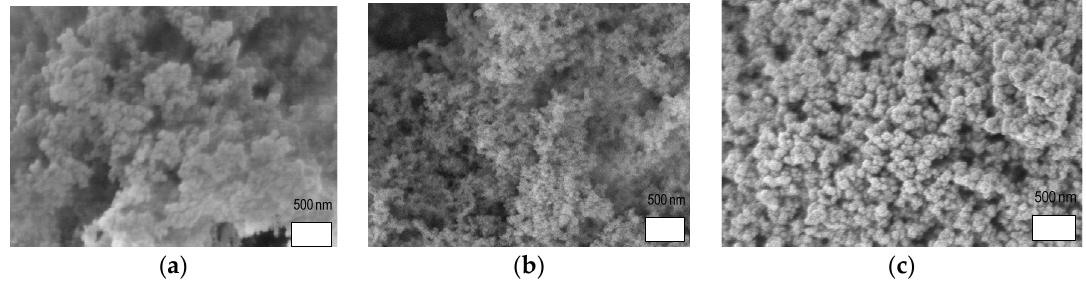
Figure 5. Morphology images of silicon dioxide nanoparticles: ( a ) untreated; ( b ) silane-treated; and ( c ) plasma-treated.